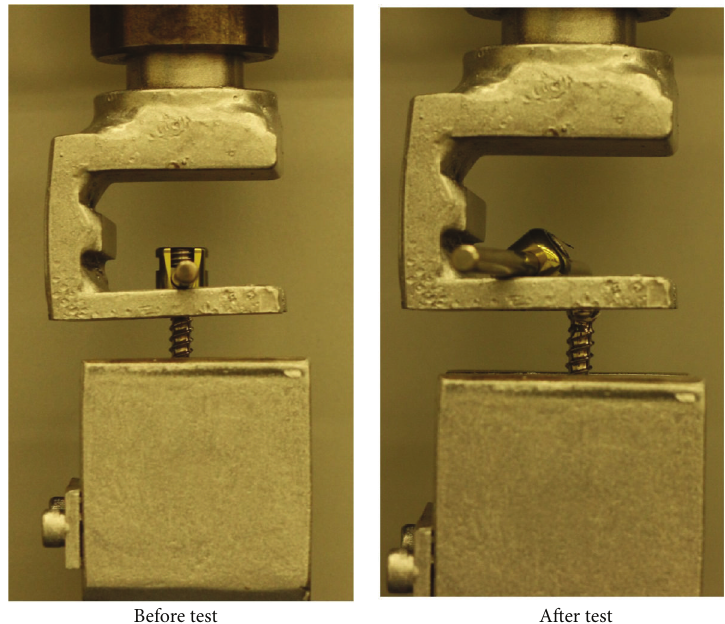
Figure 5: Pullout test, before and after.